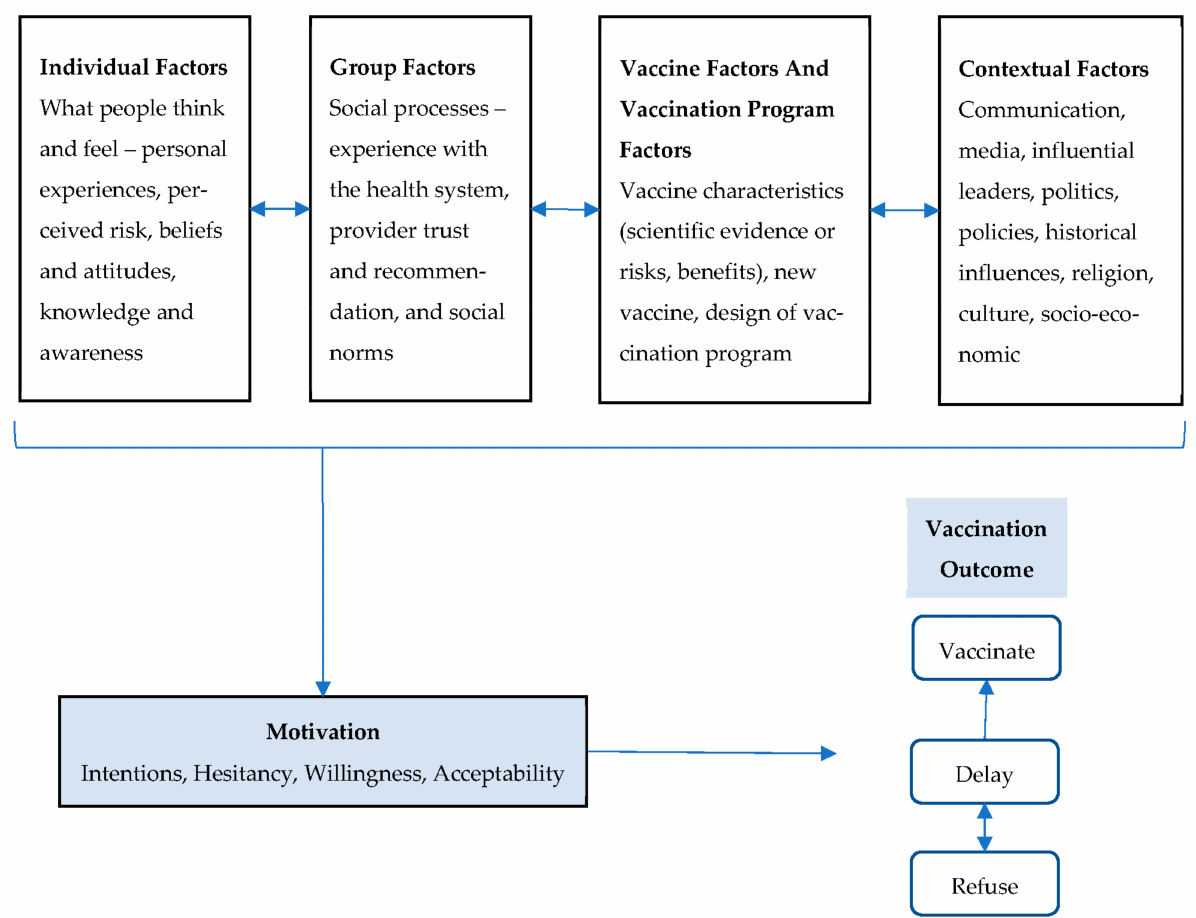
Figure 1. Factors influencing parental and individual vaccine decision making: COVID-19 and routine vaccines. Adapted from: WHO Vaccine Hesitancy Matrix developed by the Strategic Advisory Group of Experts on Immunization Vaccine Hesitancy Working Group (2015) [1], and Brewer, N.T.; Chapman, G.B.; Rothman, A.J.; Leask, J.; Kempe, A. Increasing vaccination: Putting psychological science into action. Psychol. Sci. Public Interest 2018 , 18 149–207